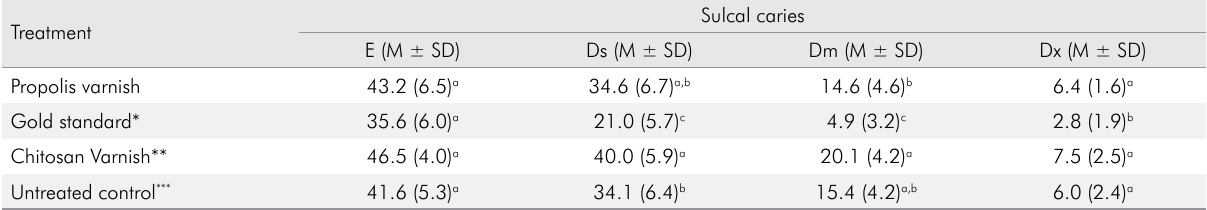
Table 3. Effects of the treatment with the experimental propolis varnish on the development and severity of sulcal caries in rats. The values of the of the caries scores are given as mean ± standard deviation using the Keyes’ classification modified by